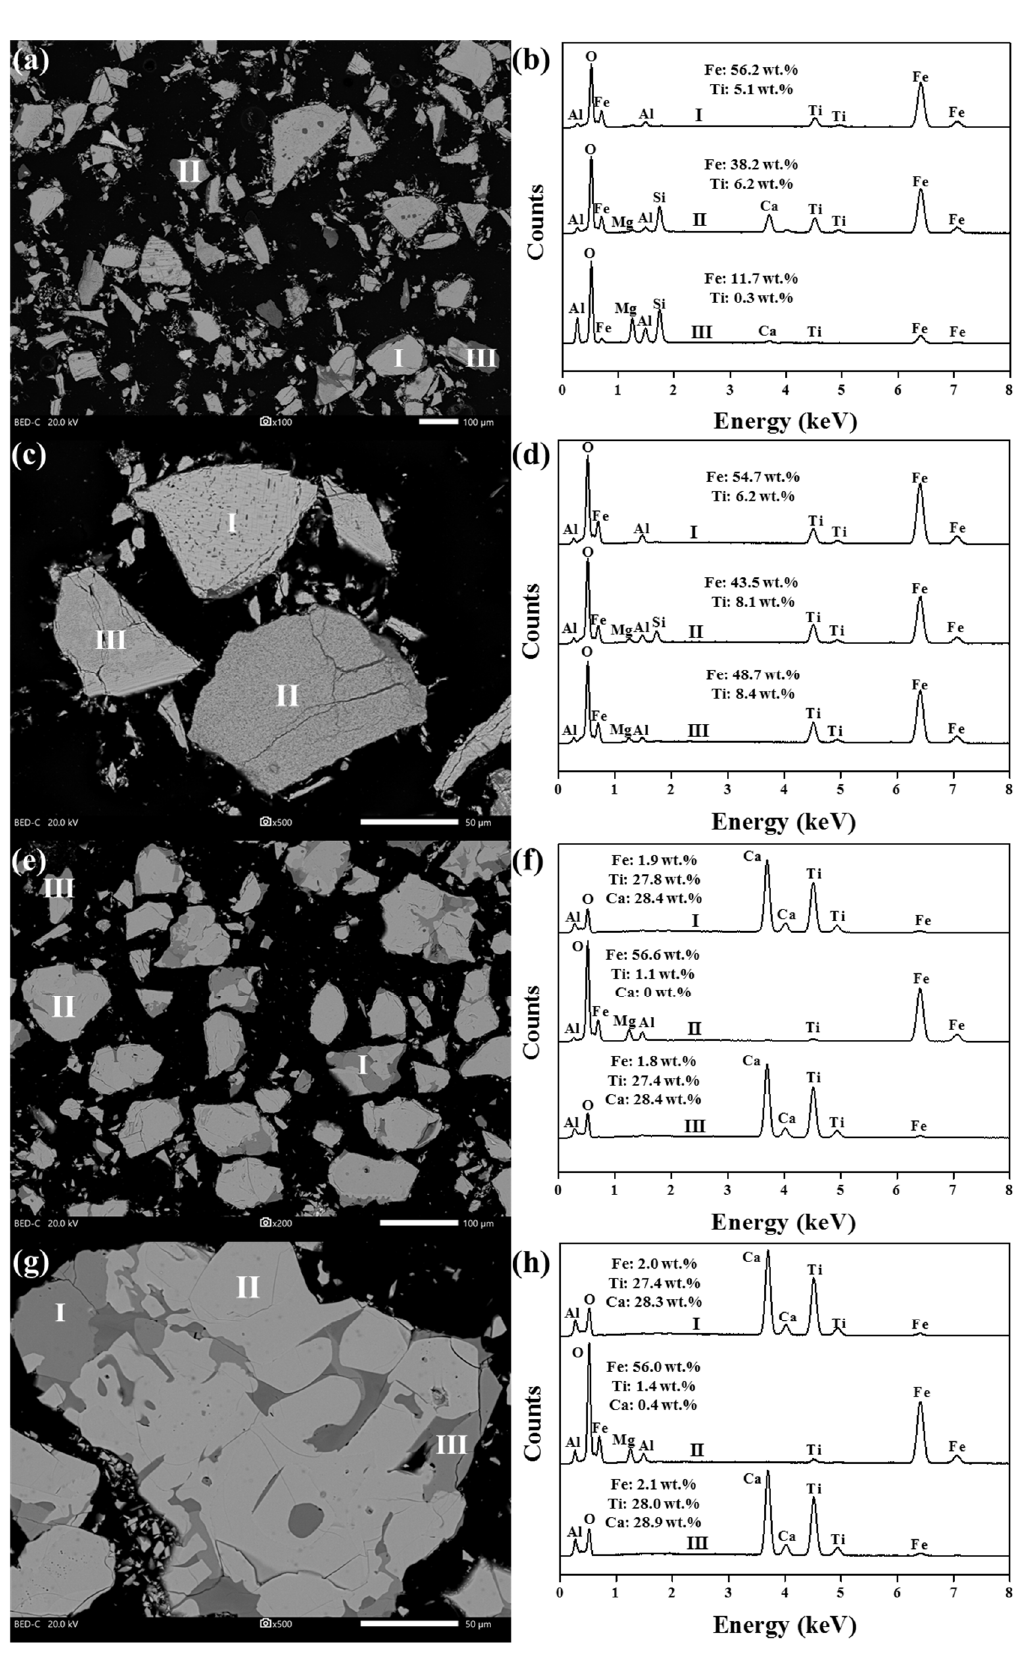
Figure 3. SEM-EDS analysis of TC ( a – d ) and roasted sample ( e – h ) under different multiples (( a , b ) × 100, ( e , f ) × 200, ( c , d ) and ( g , h ) × 500, the roman numerals in the SEM images denote the testing area used for EDS).